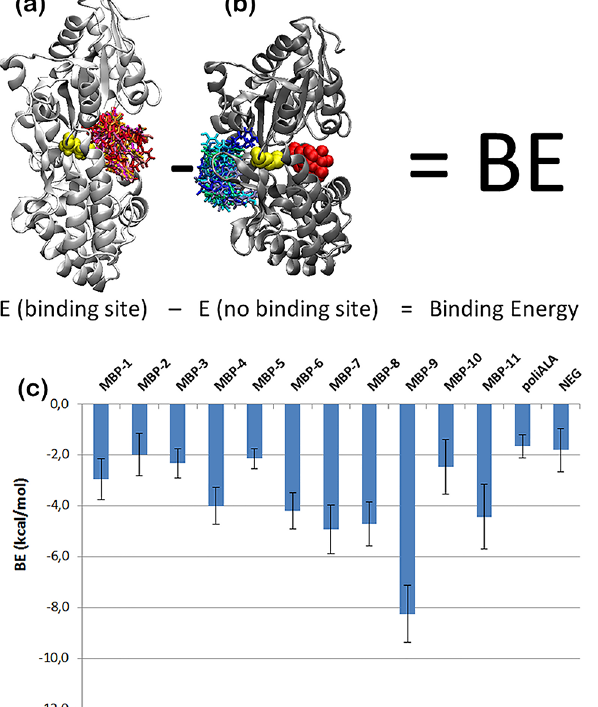
Fig 3. (a-b) Overlap of the 10 peptides final configurations obtained by redocking 10 times MBP-9 with the Vina+MC code for 100 steps at kBT = 0.6 on the Met330 site of the MBP (yellow) in open conformation (a) and in its maltotriose (red) containing closed conformation (b). (c) The MC+Vina calculated BE where the errorbars are the sums of the standard errors of the means calculated over the last 10 configurations of 10 runs of the docking protocols.